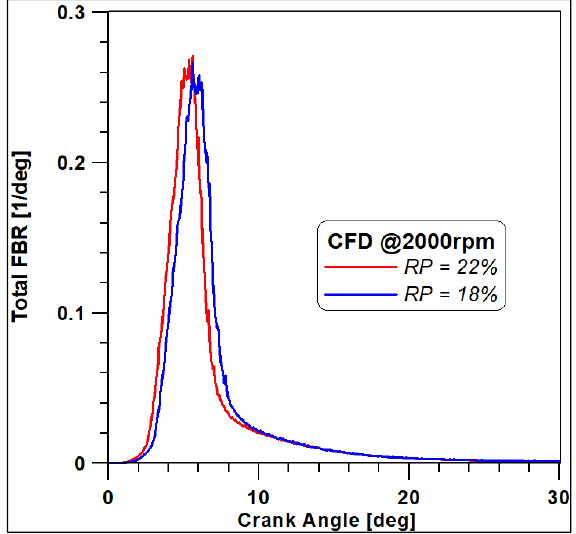
Figure 18. Total fuel burning rate for the RP = 22 and 18% at 2000 rpm cases .